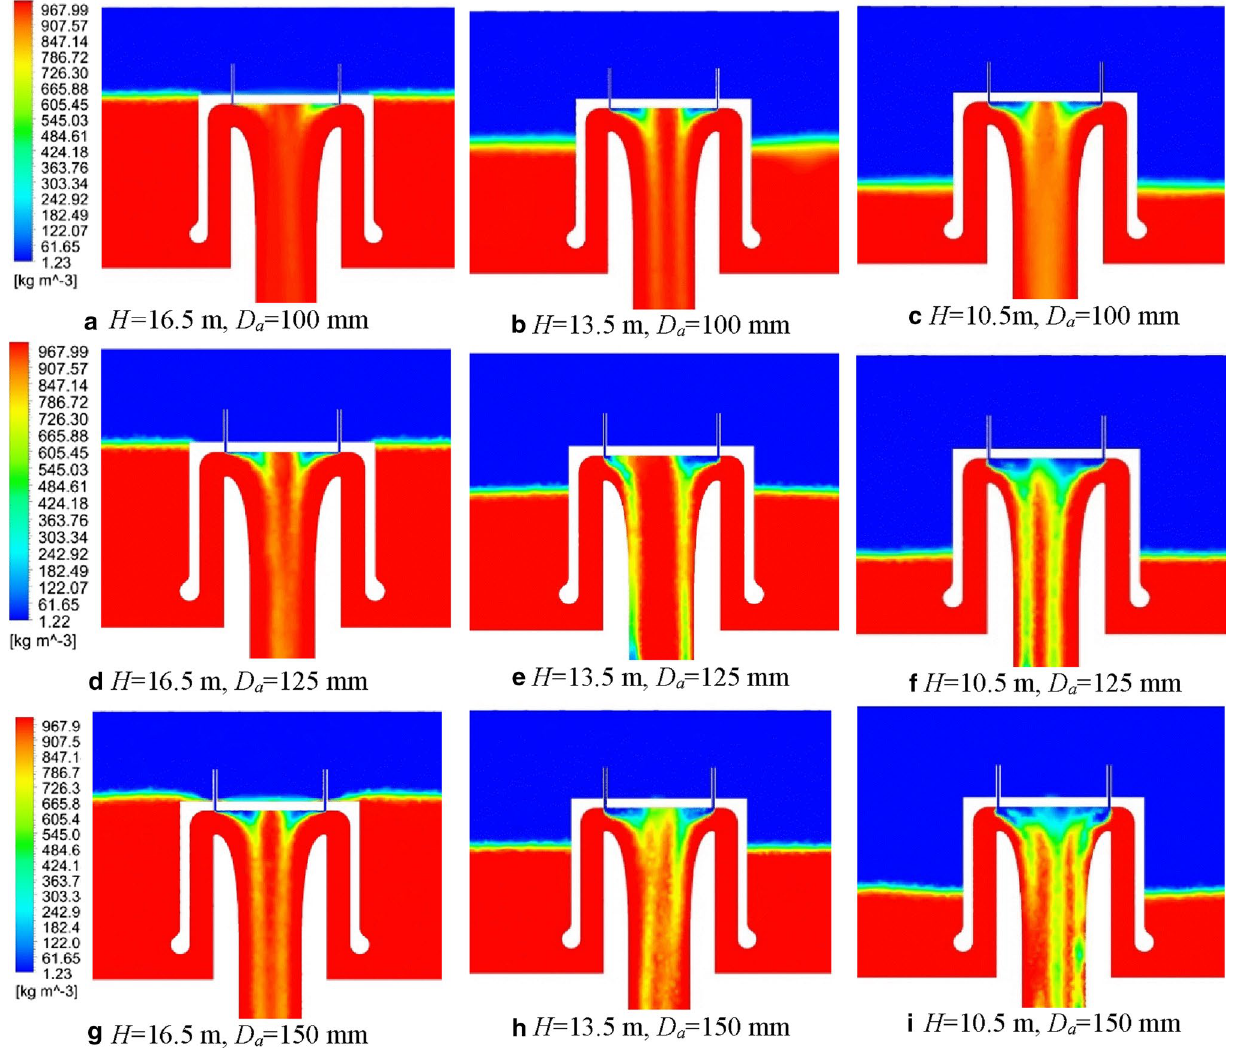
Fig. 5 Air–water mixing for different aeration diameters and operating